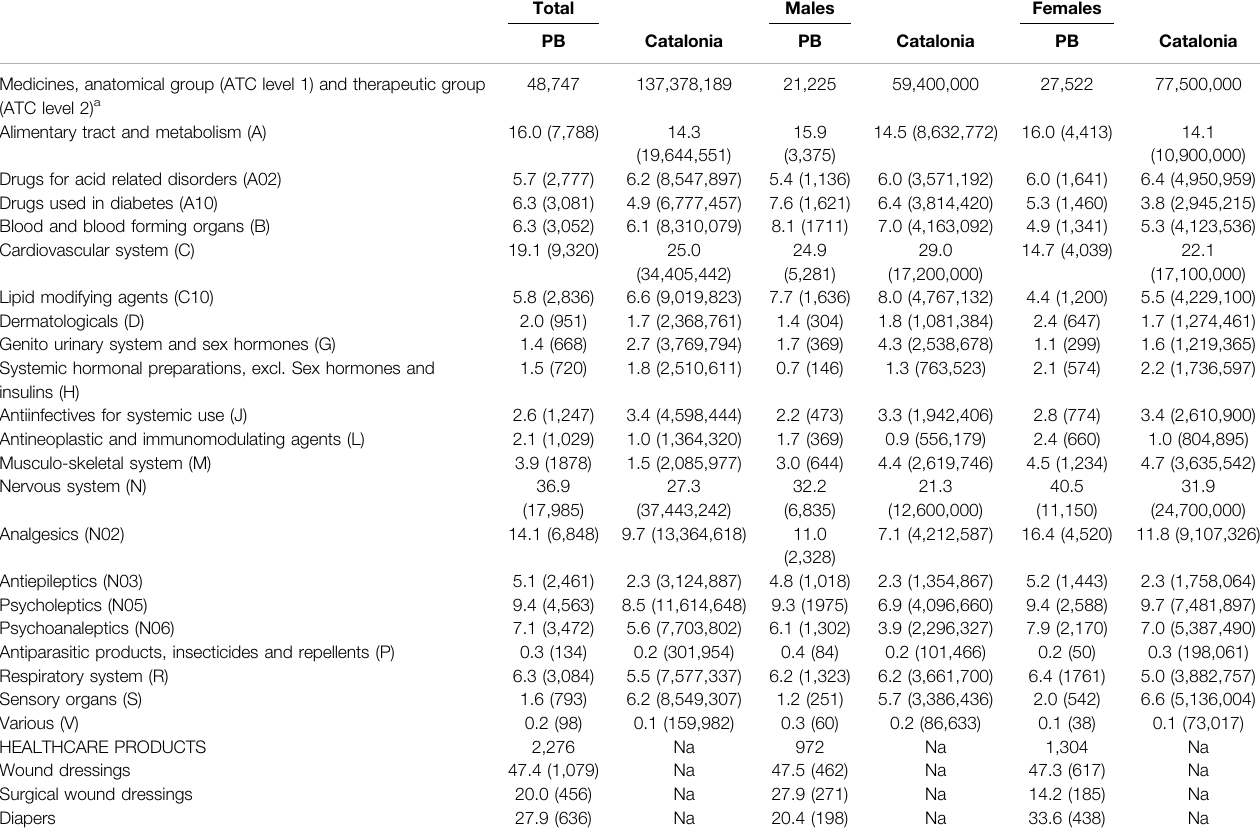
TABLE 4 | Proportion of medicines and products used by the bene fi ciaries and the general population, % (N).